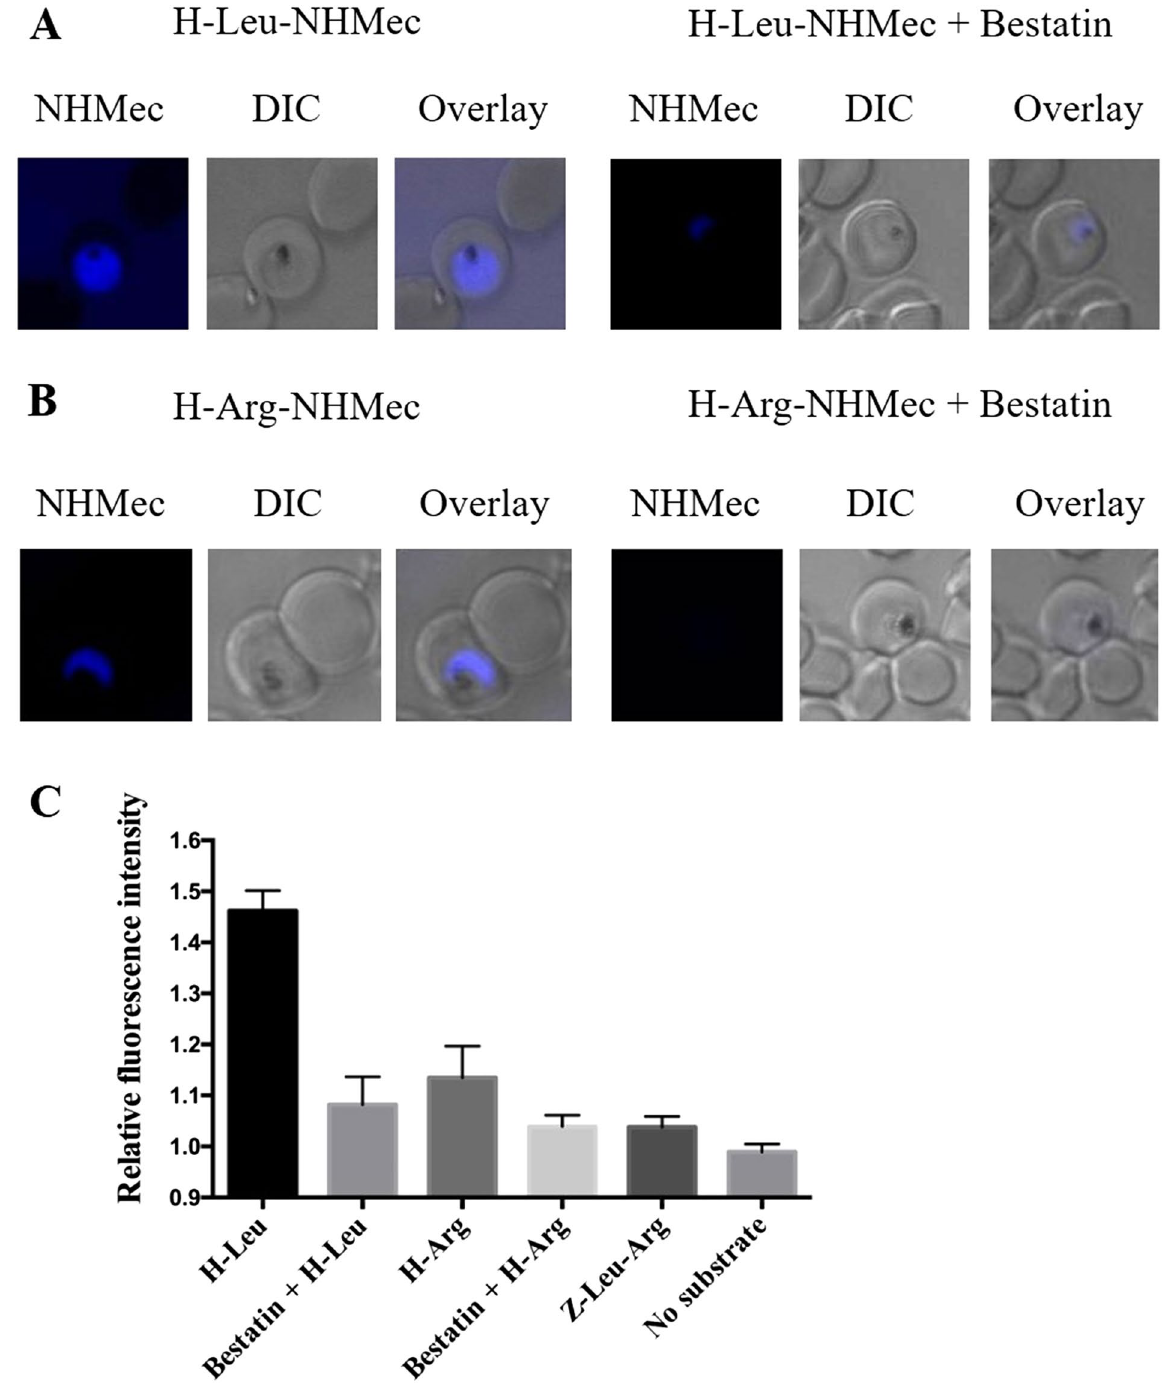
Figure 6. Proteolytic cleavage of fluorogenic substrates by Pf M1AAP and Pf M17LAP in the cytosol of live parasites. Erythrocytes infected with 3D7 P. falciparum parasites were incubated with either ( A ) 10 µM H-Leu- NHMec (substrate cleaved by Pf M1AAP and Pf M17LAP) or ( B ) 10 µM H-Arg-NHMec (substrate cleaved by Pf M1AAP but not Pf M17LAP) for 10 min. Proteolytic cleavage of substrates resulted in the release of the fluorescent free NHMec fluorophore in the parasite cytosol (blue staining). Previous incubation with 50 µM bestatin, an aminopeptidase inhibitor, resulted in inhibition of aminopeptidase activity, as revealed by the almost complete absence of fluorescence. Differential interference contrast (DIC) is shown for reference. ( C ) Quantification of NHMec fluorescence intensities in the cytosol relative to background (mean ± SEM). At least ten parasites were imaged per treatment under the same conditions on the same day. Z-Leu-Arg-NHMec (substrate not cleaved by Pf M1AAP or Pf M17LAP) was used for